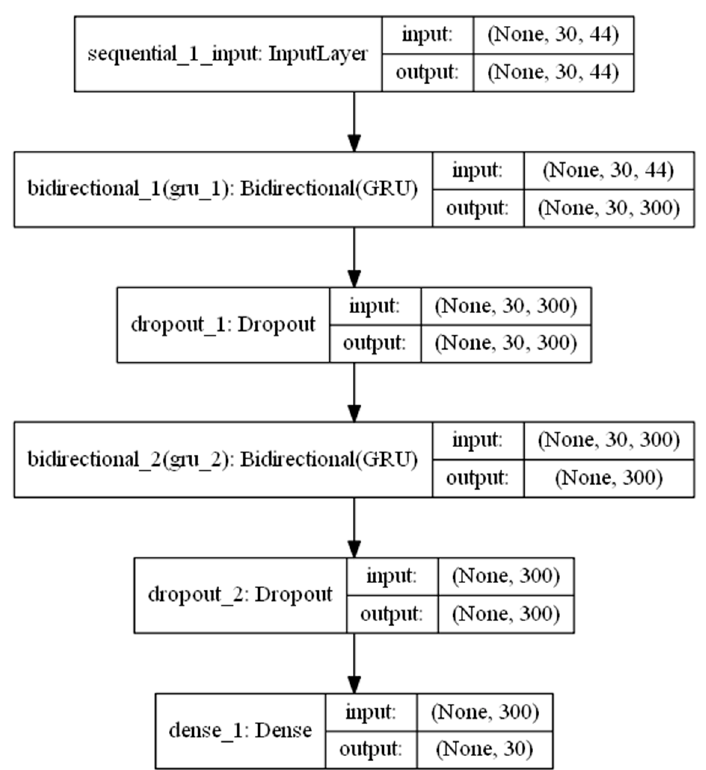
Figure 13. Model based on Architecture 1: many-to-one architecture.